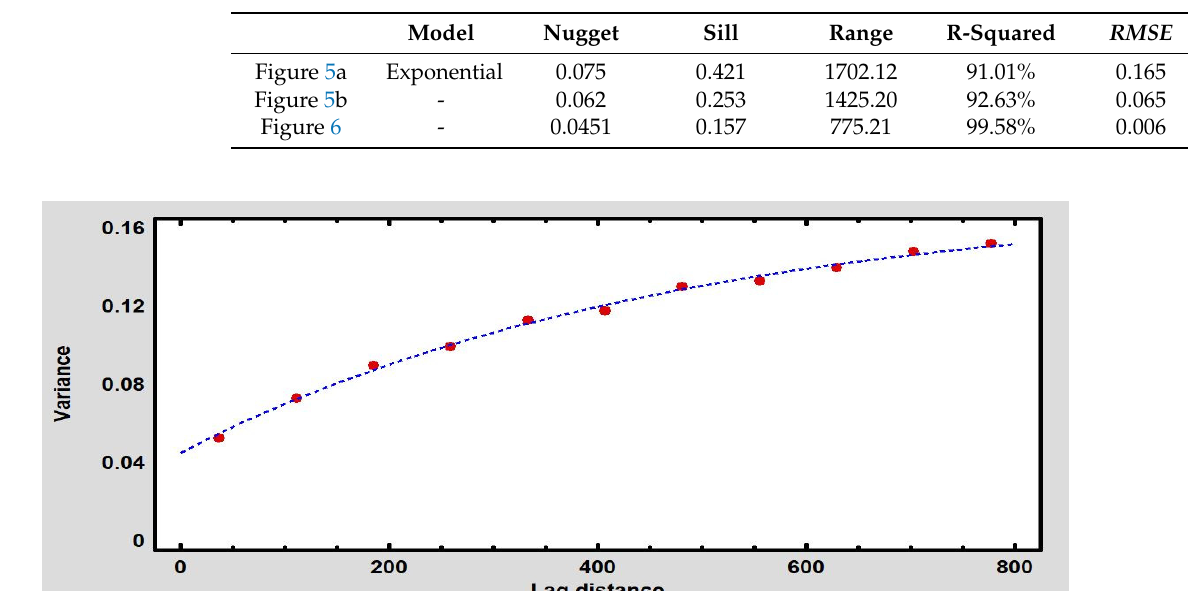
Figure 6. Final experimental variograms at R 2 = 99.58%.